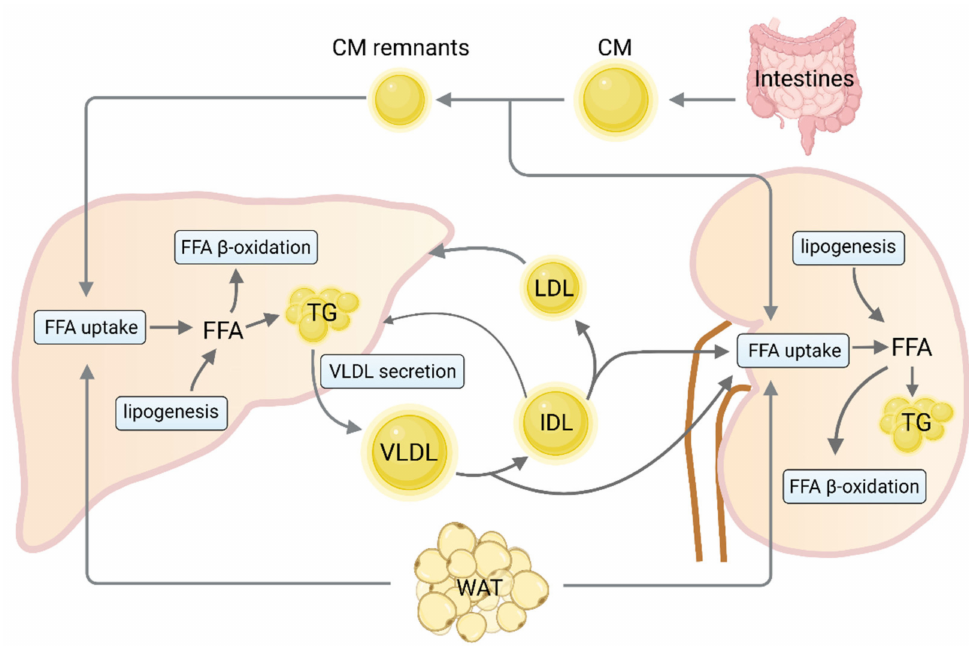
Figure 1. Cross-talk between liver and kidney in lipid metabolism. Dietary fat is incorporated into CM in the intestine and enters the circulation within two hours after food intake to deliver fatty acids to the kidney before being taken up by the liver as chylomicron remnants. In fasting state, FFA are derived from lipolysis in WAT and are actively taken up by various FA transporters. FFA derived from de novo lipogenesis or circulating are esterified to predominantly produce TG stored within lipid droplets. TG in the liver is packed into VLDL particles and exported into the blood stream for the delivery of fat to the kidney. Alternatively, fatty acids can be oxidized, primarily via β - oxidation, for energy production in the liver and kidney. This figure was created with BioRender.com (accessed on 2 October 2021). CM, chylomicrons; FFA, free fatty acid; WAT, white adipose tissue; TG, triglycerides; VLDL, very low-density lipoproteins; IDL, intermediate-density lipoprotein; LDL, low-density